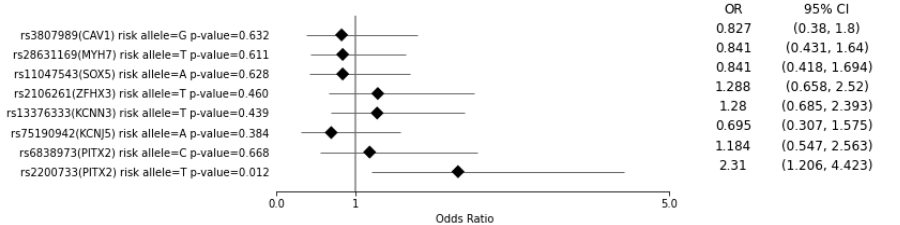
Figure 1. AF occurrence risk per single tested variant. The odds ratio (OR) and 95% confidence interval (CI) are from the multivariate logistic regression analysis ( n = 367) (Table S1).